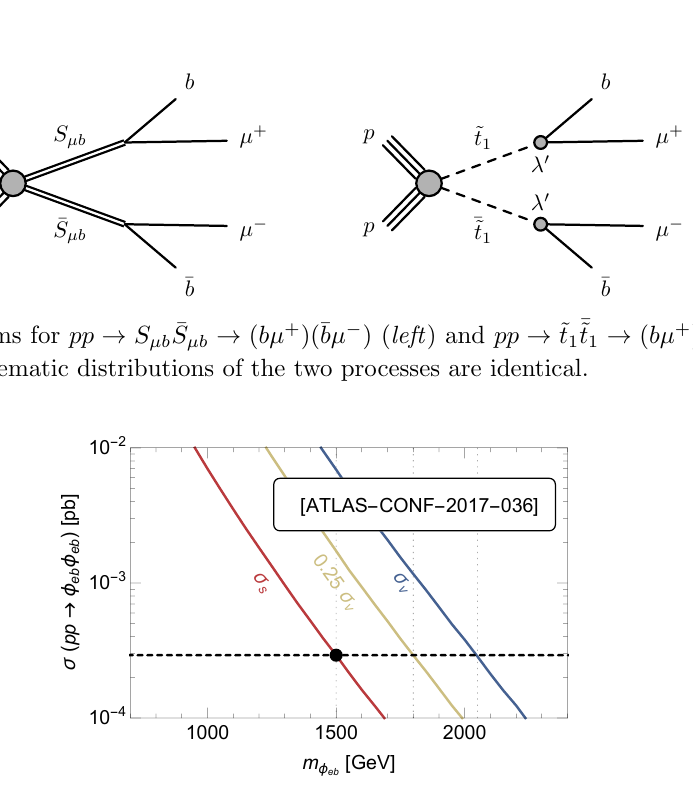
(cid:22)~ t 1 ! ( b(cid:22) + )((cid:22) b(cid:22) (cid:0) ) ( right ). 1